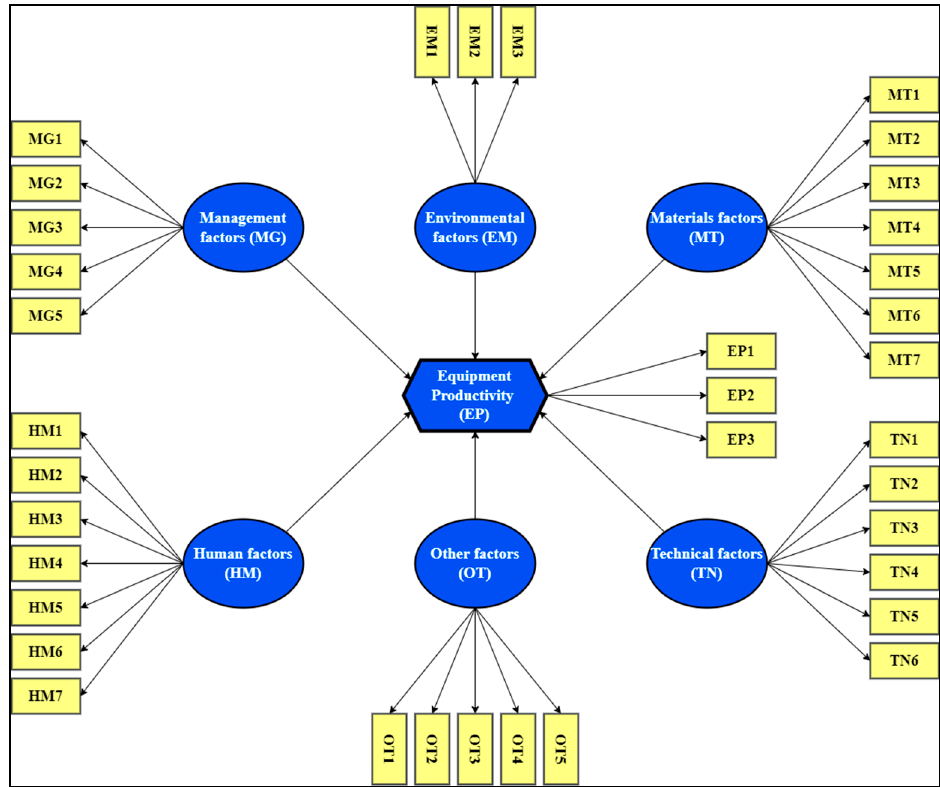
Figure 2. Hypothesis development using